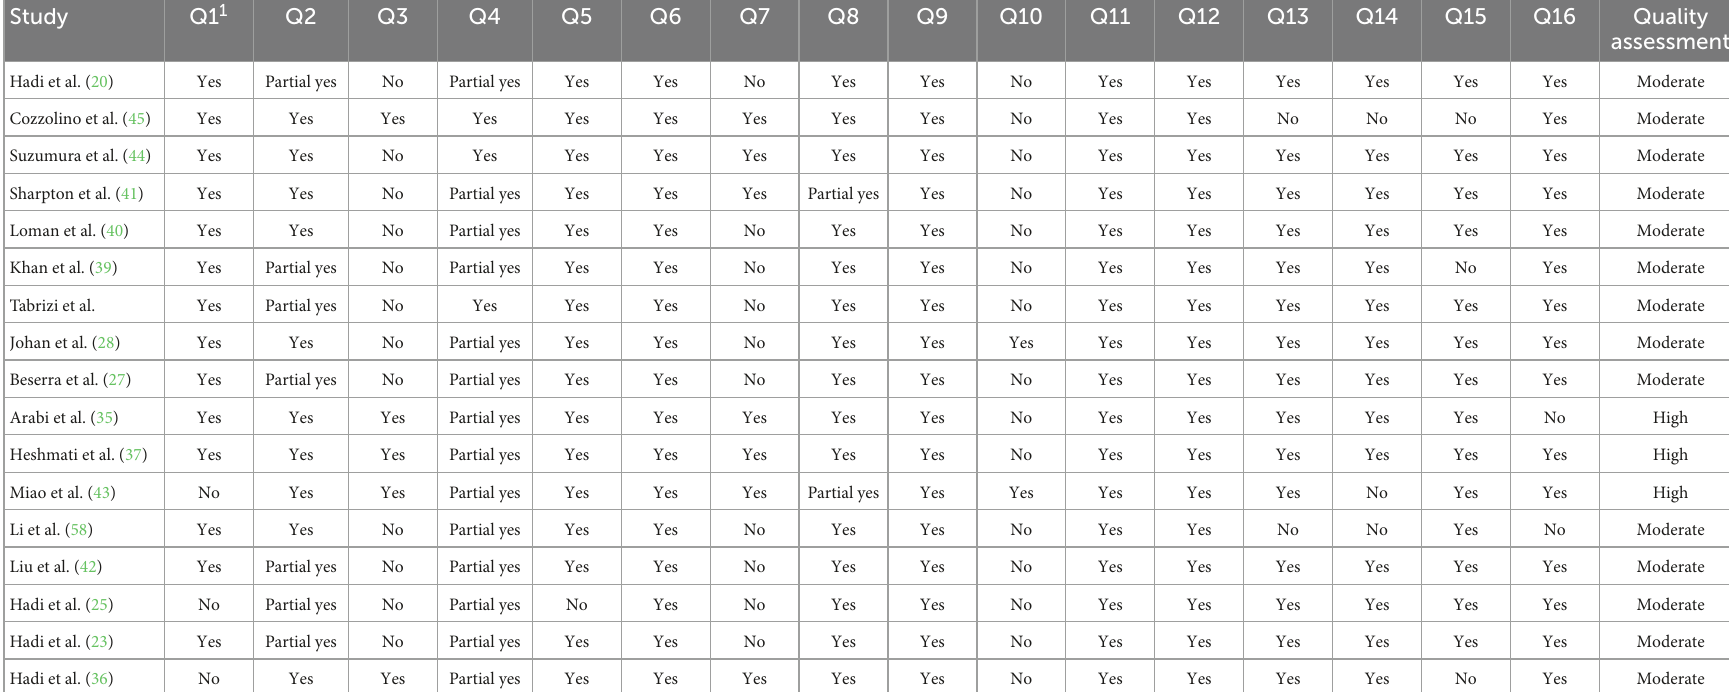
TABLE 2 Results of assess the methodological quality of